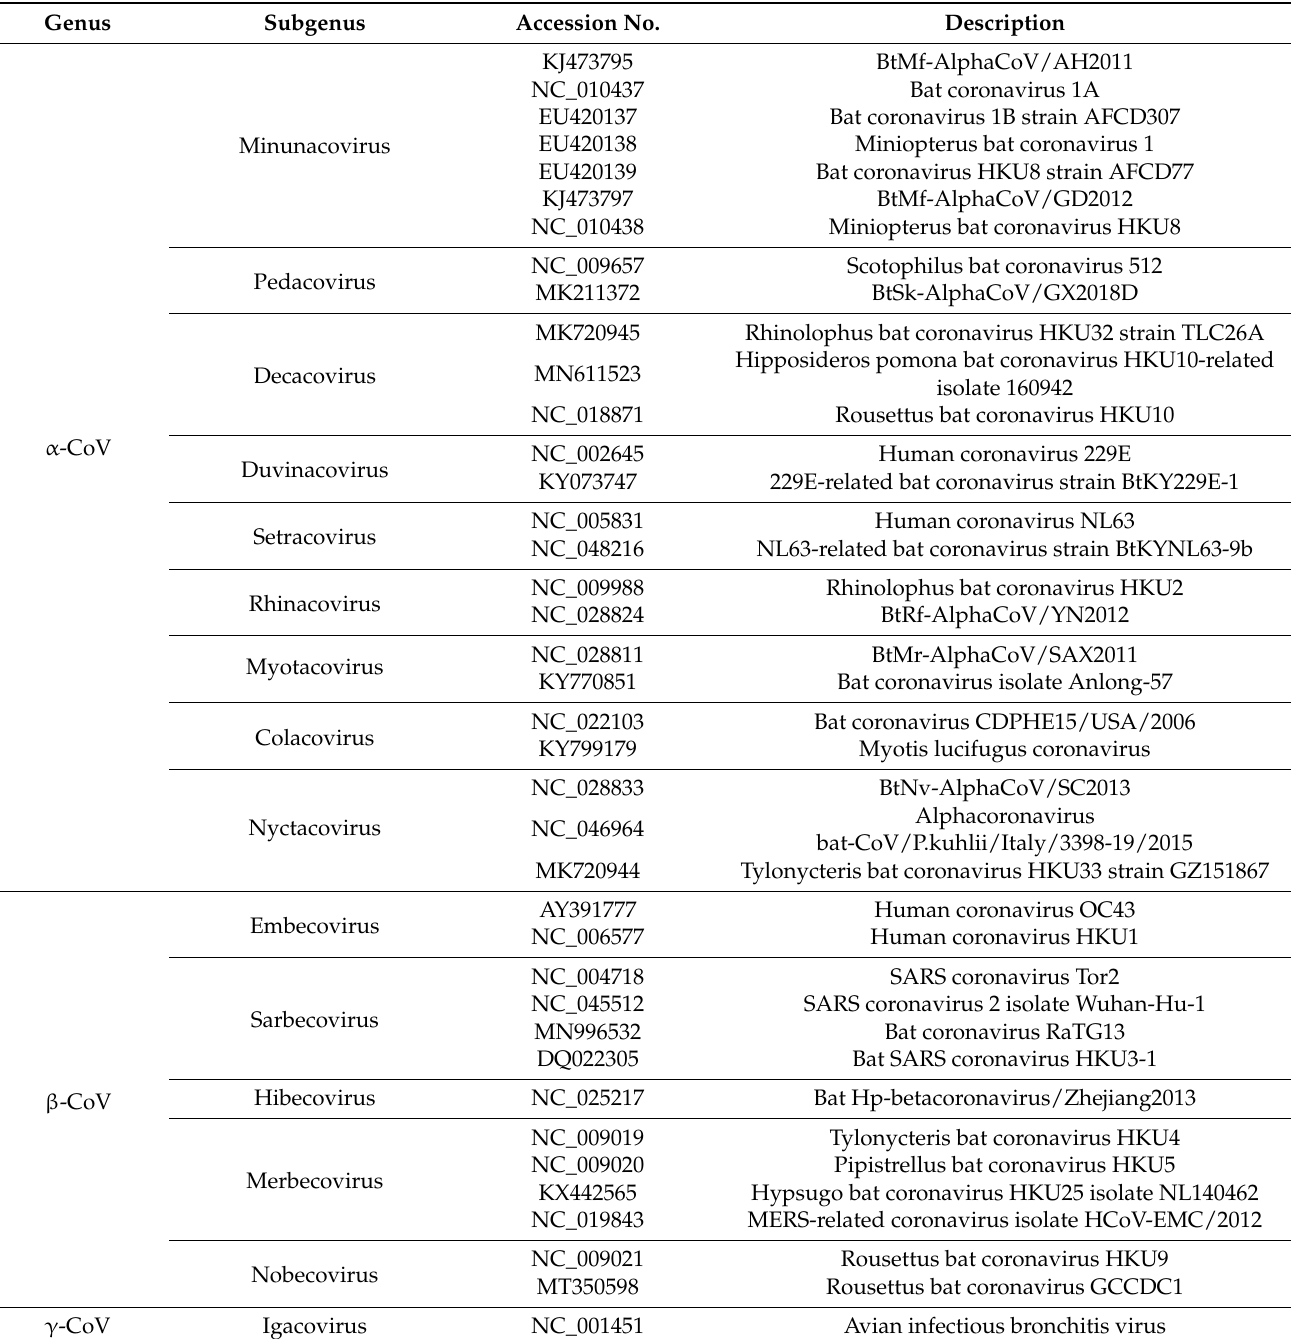
Table 1. Overview of α -Coronaviruses (-CoVs), β -CoVs and γ -CoV from the NCBI database that were selected for the genomic and phylogenetic